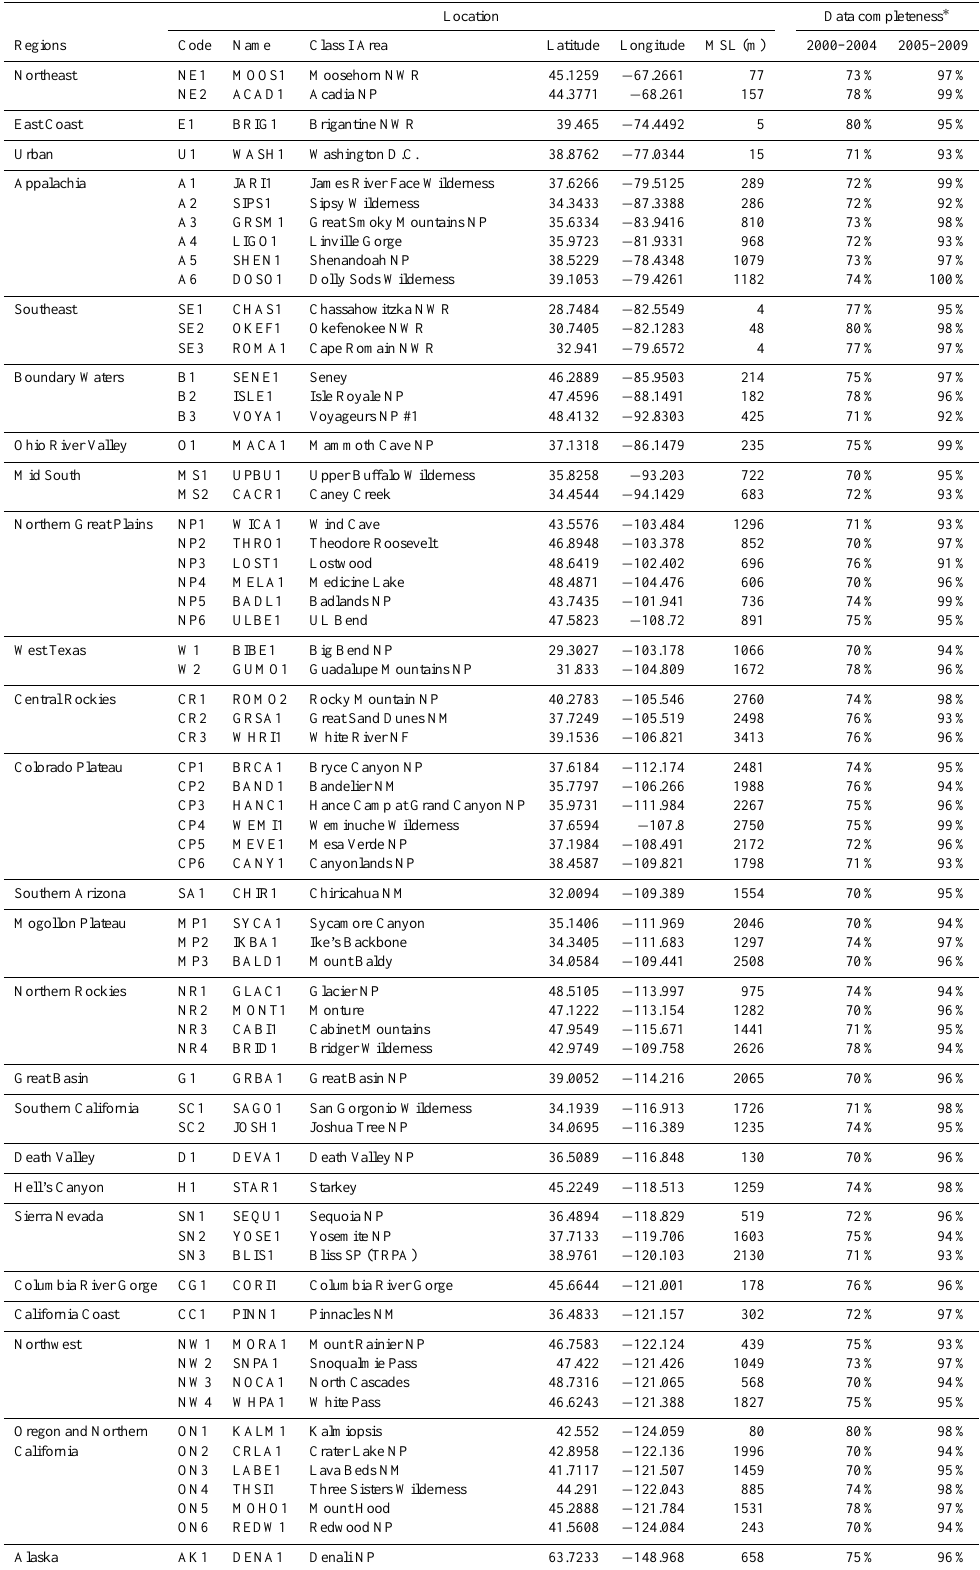
Table 1. Region, location, and data completeness (2000–2009) of EC and τ R for 65 IMPROVE sites selected for this study. Location Data completeness